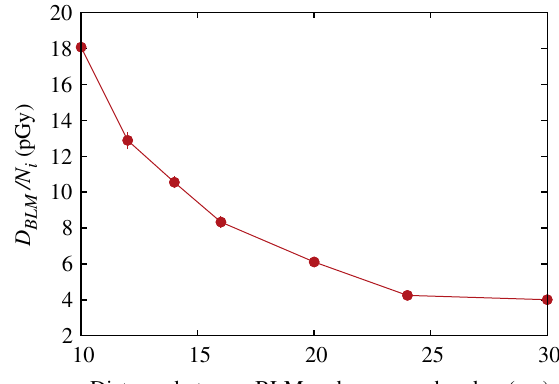
FIG. 4. Example of the simulated BLM response as a function of the radial distance between the vacuum chamber and BLM (center to center). The chamber and monitor are oriented parallel to each other. As source term, we consider collisions of 3.5 TeV protons with the LHC wire scanner (carbon fiber). For simplicity, the spatial loss distribution was assumed to be pointlike. Signals are expressed per inelastic proton-nucleus collision N i in the wire. Vertical bars indicate, where visible, the statistical error of simulation